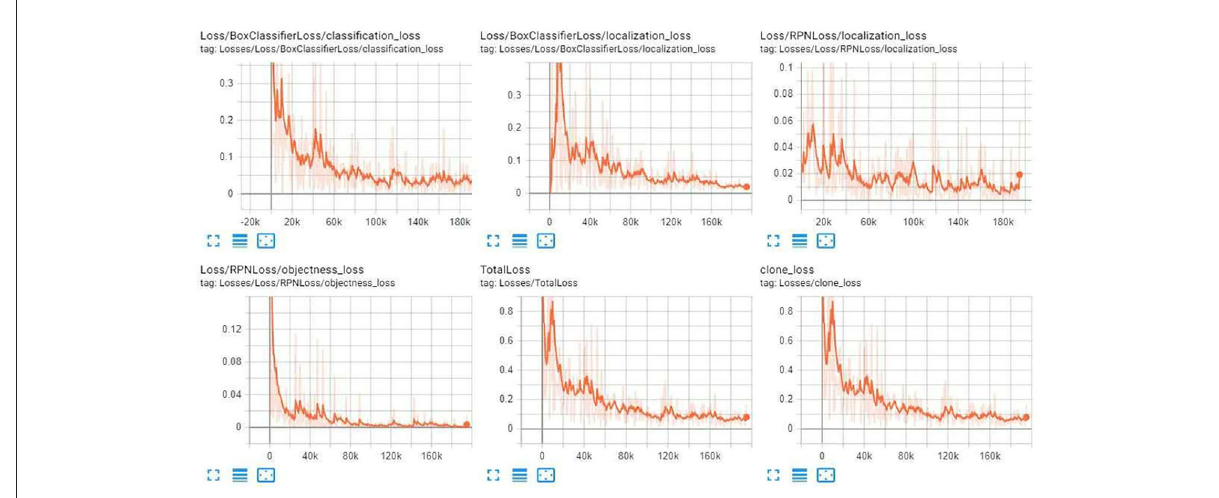
FIGURE10 Inception V2-coco training loss graph.